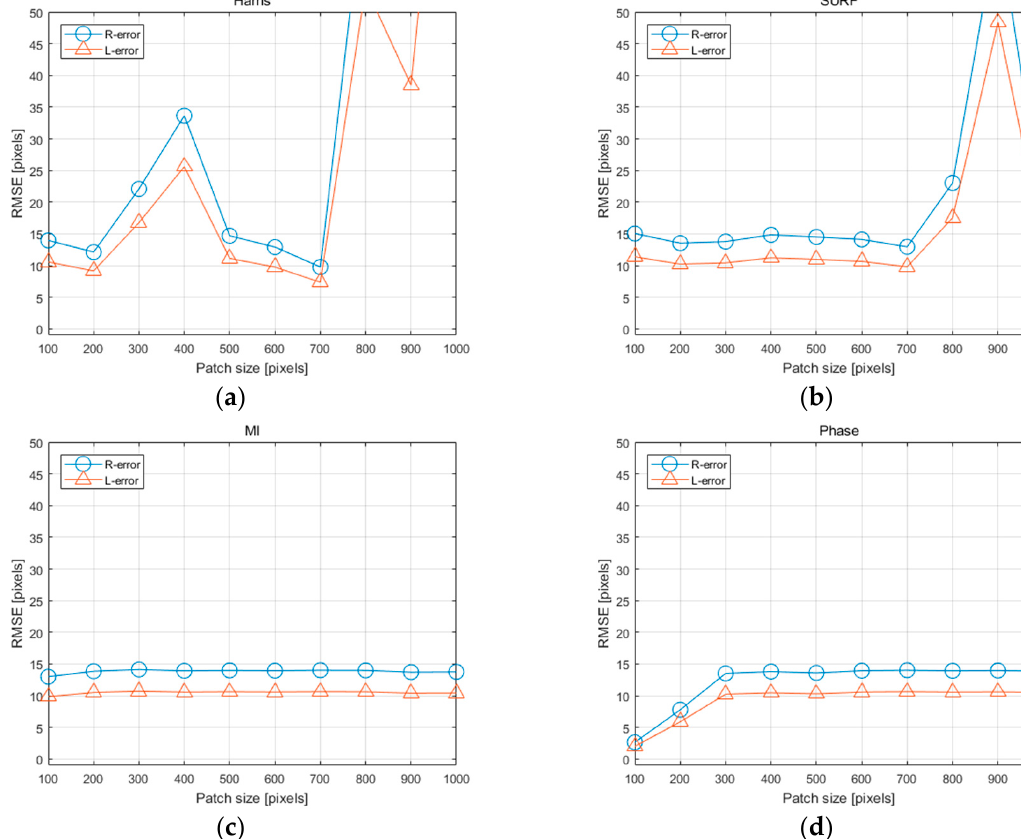
Figure 17. Reprojection errors (across-track Kompsat-3A coarse epipolar—before adjustment): ( a ) HARRIS–FREAK ( b ) SURF, ( c ) MI, and ( d ) PC.